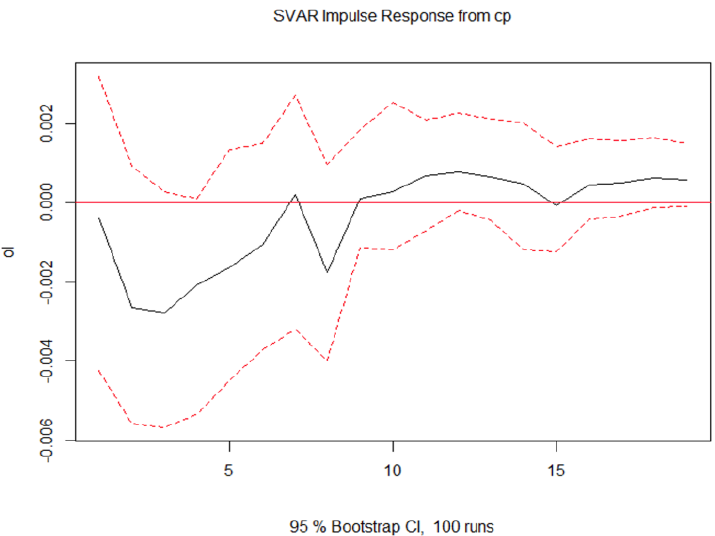
Figure 4: The SVAR Impulse Response of crude oil price from corona panic index; Sources: Author’s compilation